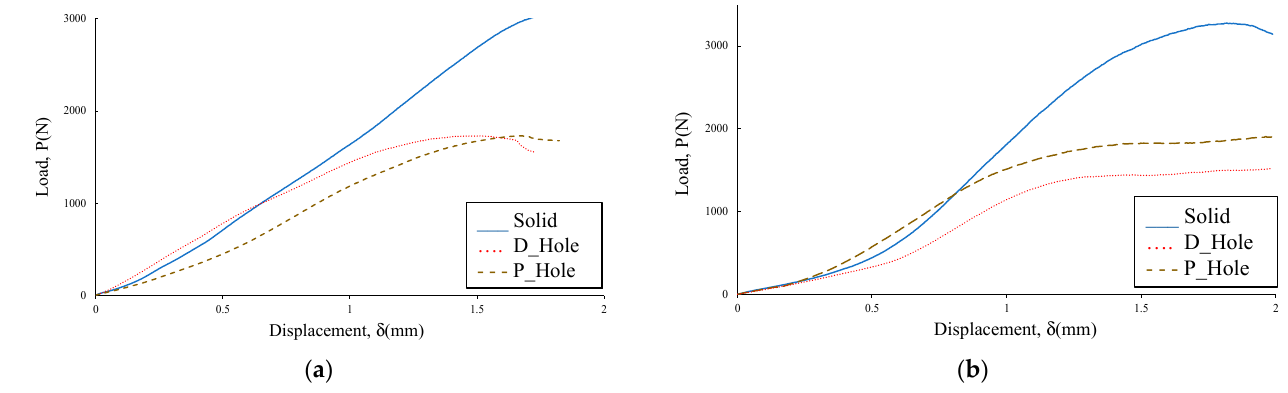
Figure 6. Typical experimental curves for NACA 23015: ( a ) PLA; ( b ) CF-PLA.